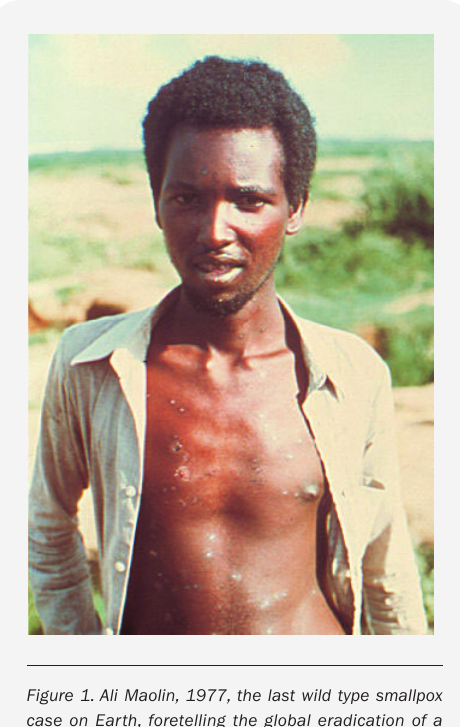
Figure 1. Ali Maolin, 1977, the last wild type smallpox case on Earth, foretelling the global eradication of a disease that once killed half of all human children